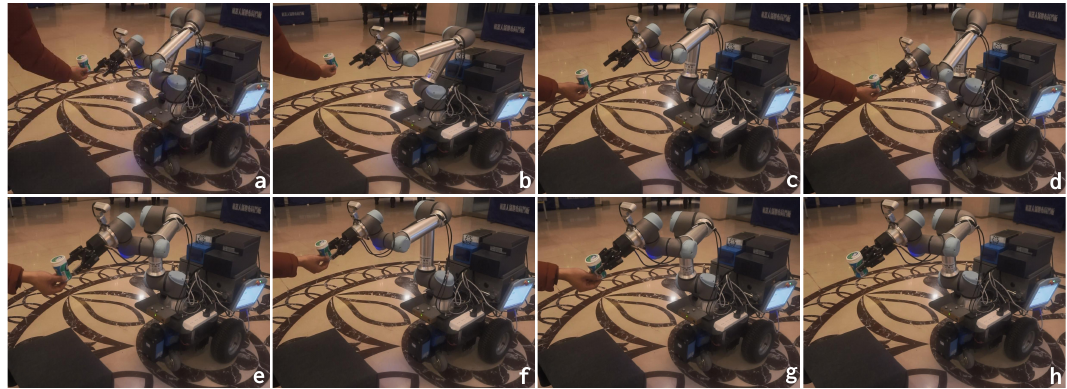
Figure 14. The process of dynamic tracking grasp. ( a ) Detecting the object. ( b , c ) Approaching the object. ( d – f ) Dynamically tracking the object. ( g , h ) Grasping the